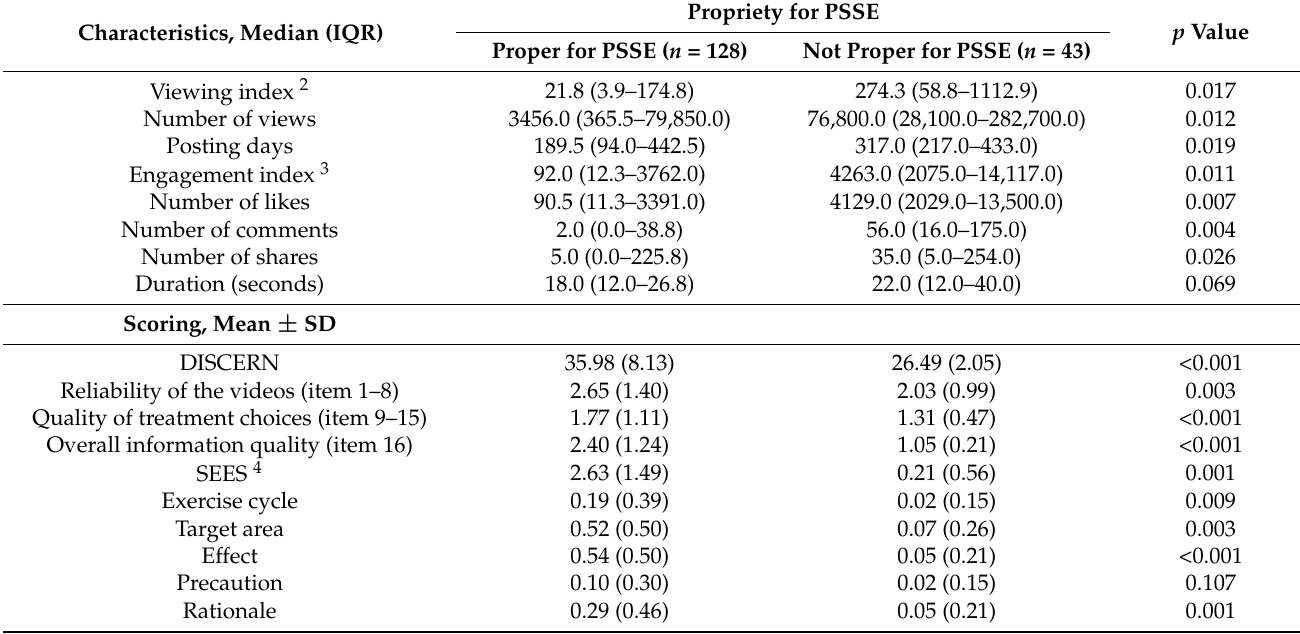
Table 3. Characteristics of the videos across propriety for PSSE 1